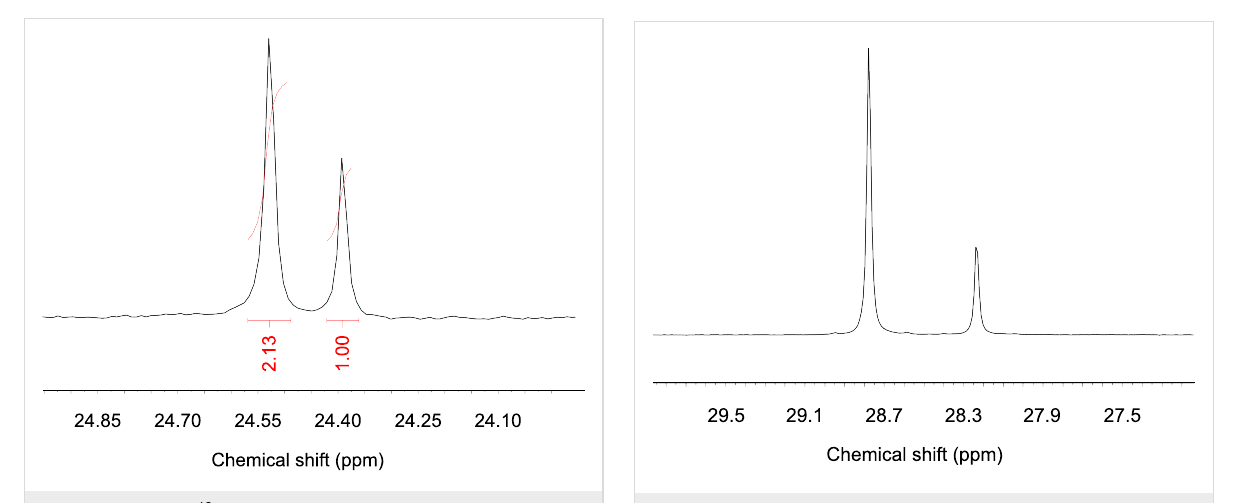
Figure 2: Portion of 13 C NMR spectrum of 7 showing 2.1:1 ratio of diastereoisomeric isotopomers.